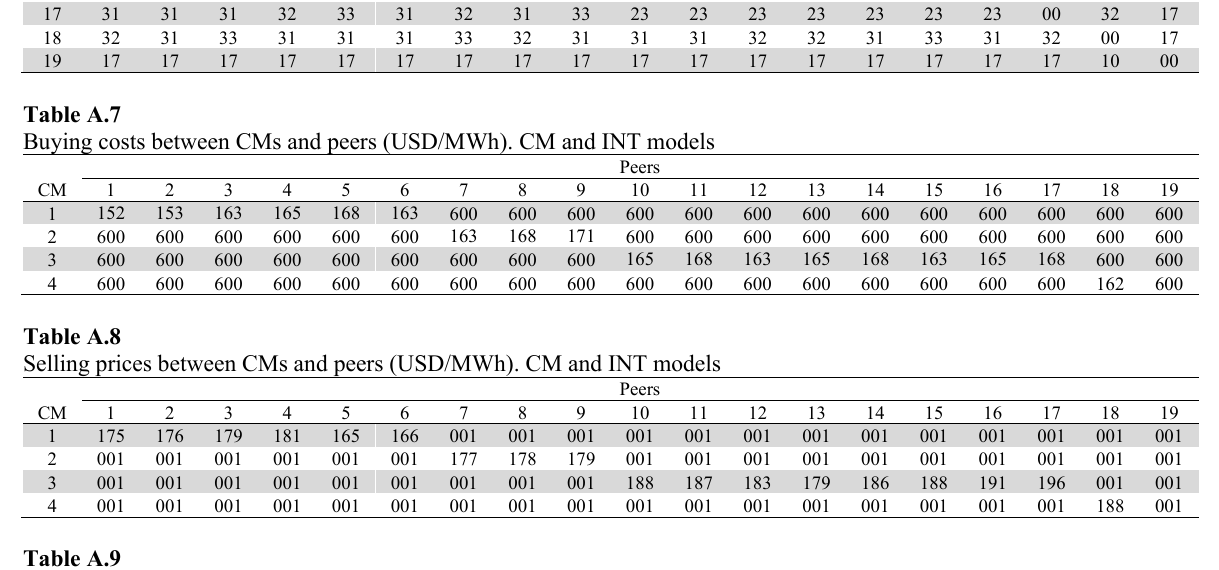
Cost for using transmission lines (USD/MW). CM model and INT models CM